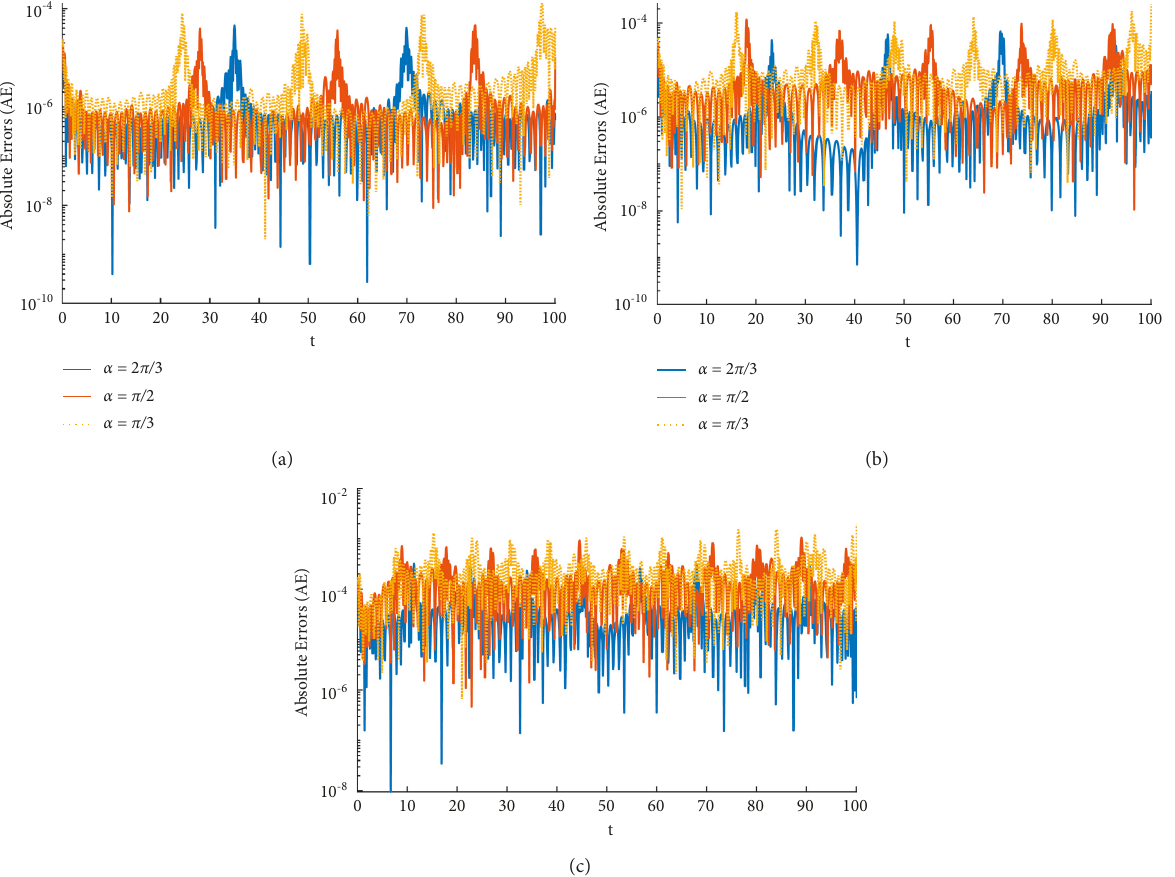
Figure 4: Absolute errors in solutions of CNN-BLM algorithm for different cases of scenarios 1, 2, and